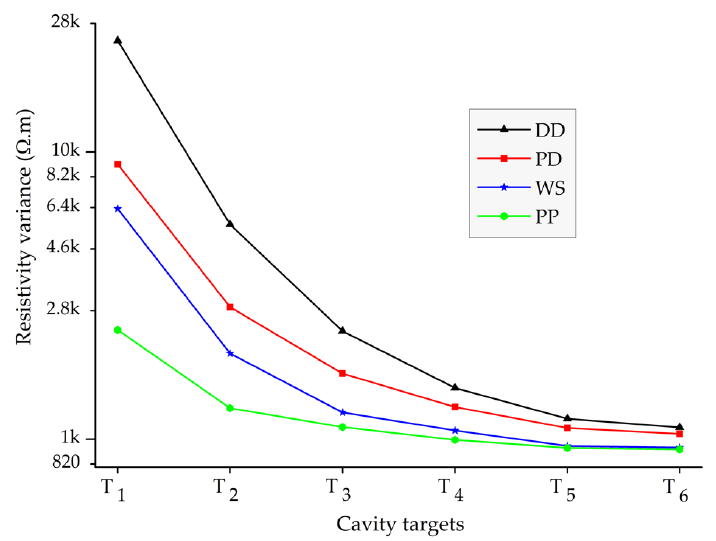
Figure 2. The variance of the numerically measured resistivity data for air-filled cavity situated at different survey depths.